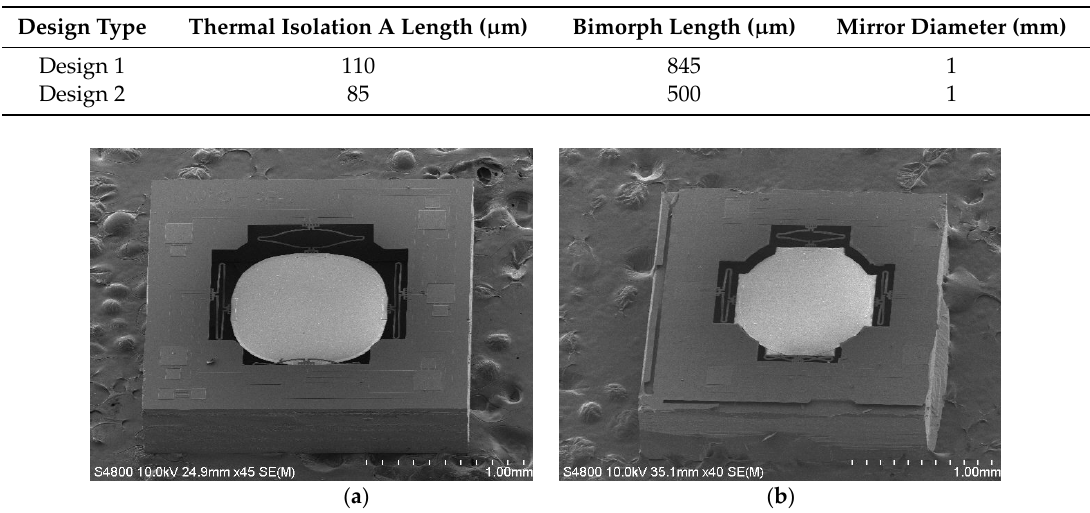
Table 1. Parameters of two different MEMS mirror designs.